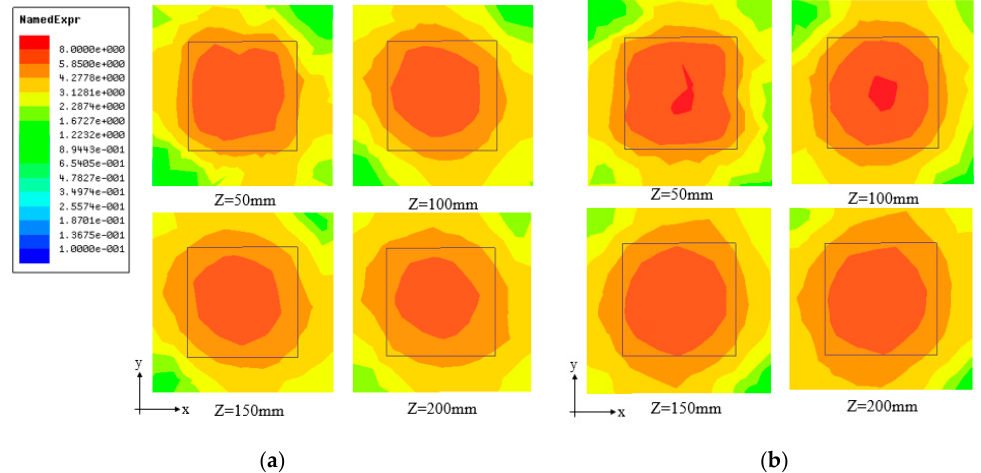
Figure 26. Simulated distribution of electric field components (Ex, Ey) at different heights for a 2 × 2 array antenna: ( a ) Ex distribution and ( b ) Ey distribution.